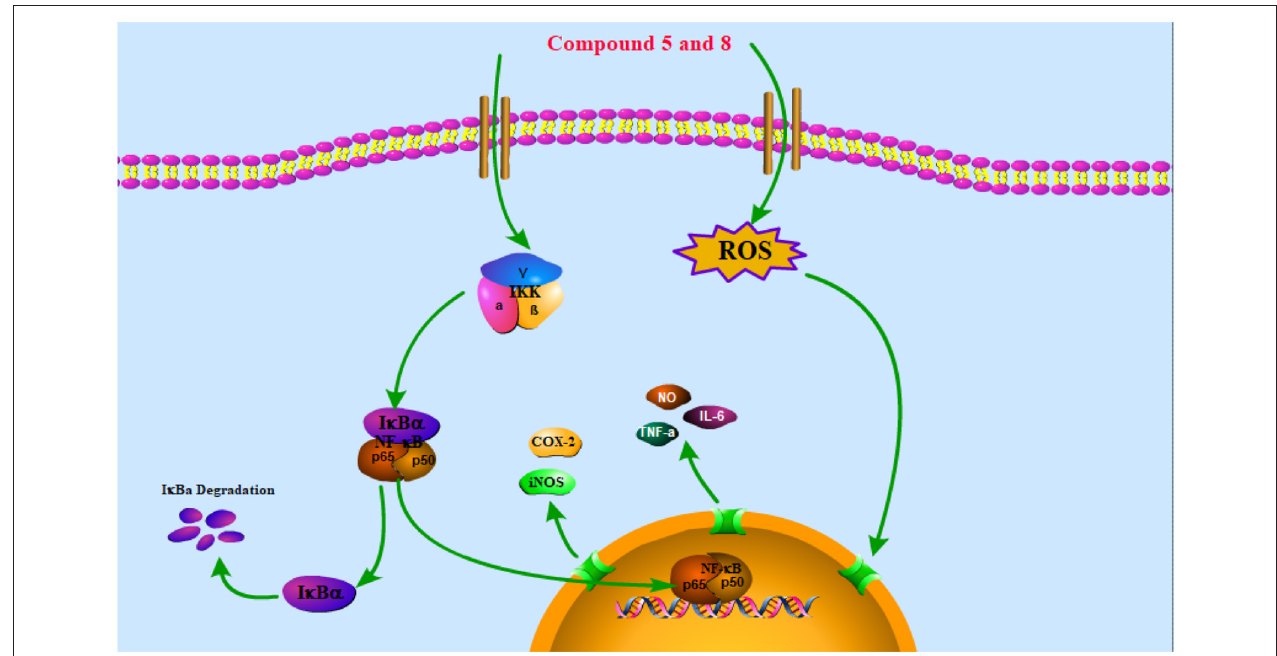
FIGURE 5 | Schematic of the potential mechanisms of the effects of compounds 5 and 8 on the NF- κ B signaling pathway in RAW264.7 macrophages. Compounds 5 and 8 exert anti-inflammatory and immune bidirectional regulation by promoting reactive oxygen species (ROS) generation and affecting the nuclear factor- κ B (NF- κ B) signaling pathway as discussed in the text. The arrows indicate the direction of the signaling